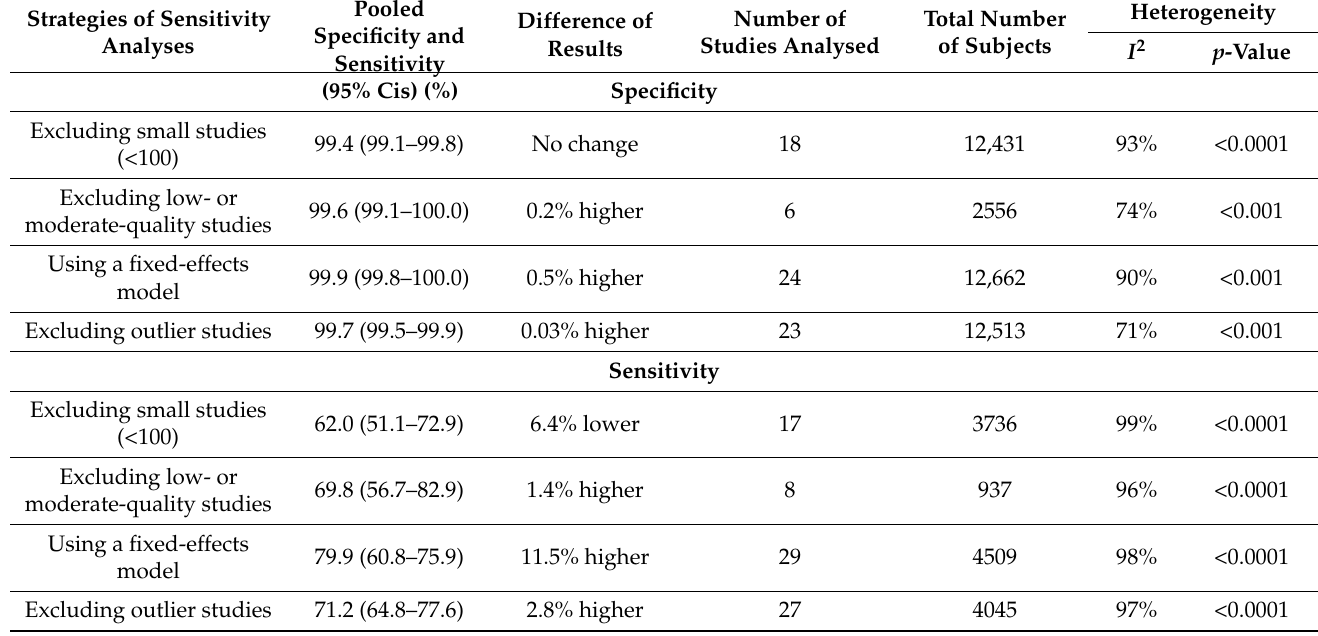
Table 3. Sensitivity